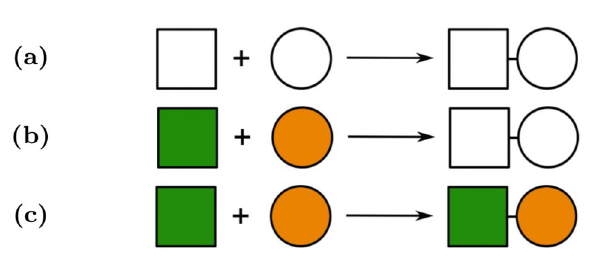
Fig 6. Example of a match-replace action. As a solution, we use the solution A from Fig 4. (A) Rule can match a square and a circle regardless their colours and form a complex. (B) We randomly choose the green square and the orange circle from the solution. The rule matched the chosen objects and they were assigned to the left-hand side of the rule. (C) The rule was applied and objects we replaced by a new complex of green square and orange circle. We obtained the reaction describing the particular action which has just happened.